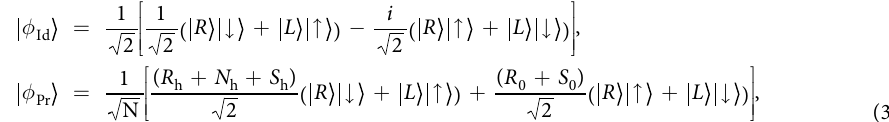
where N = | R h + N h + S h | 2 + | R 0 + S 0 | 2 . Then, we can quantify the affection of noise ˆ N and leakage ˆ S in the QD-cavity system by comparing fidelity (F QD ) between φ case). φ φ